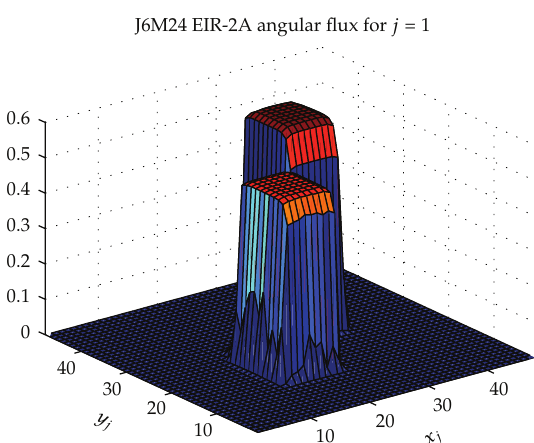
Figure 14: Angular flux in J6M24 EIR 2A.